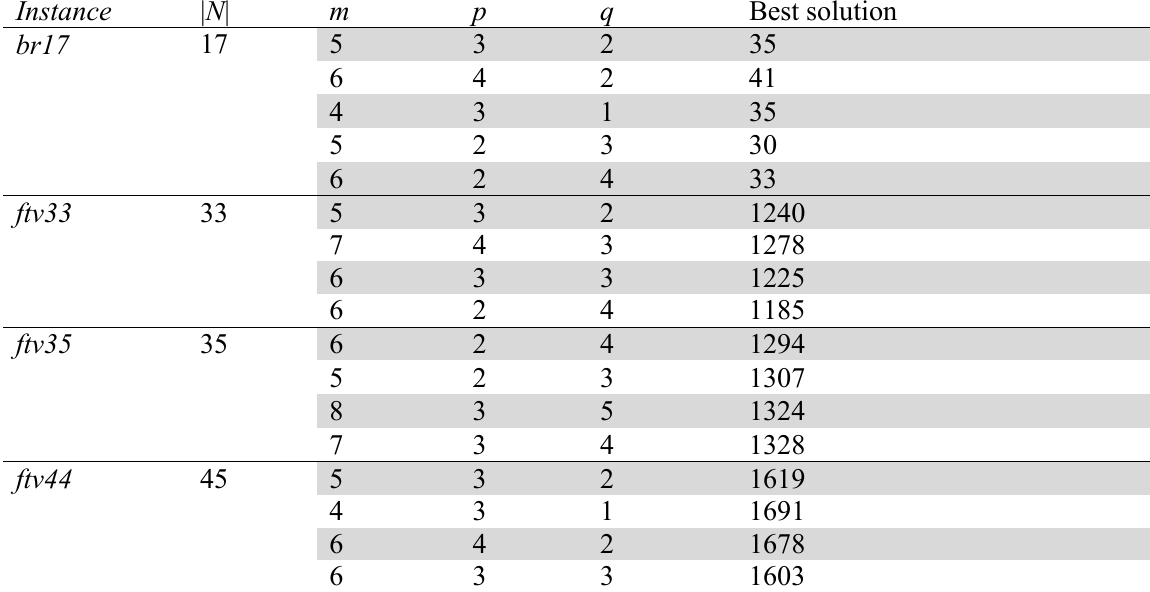
Results of LSA for OCMTSP on benchmark instances Instance